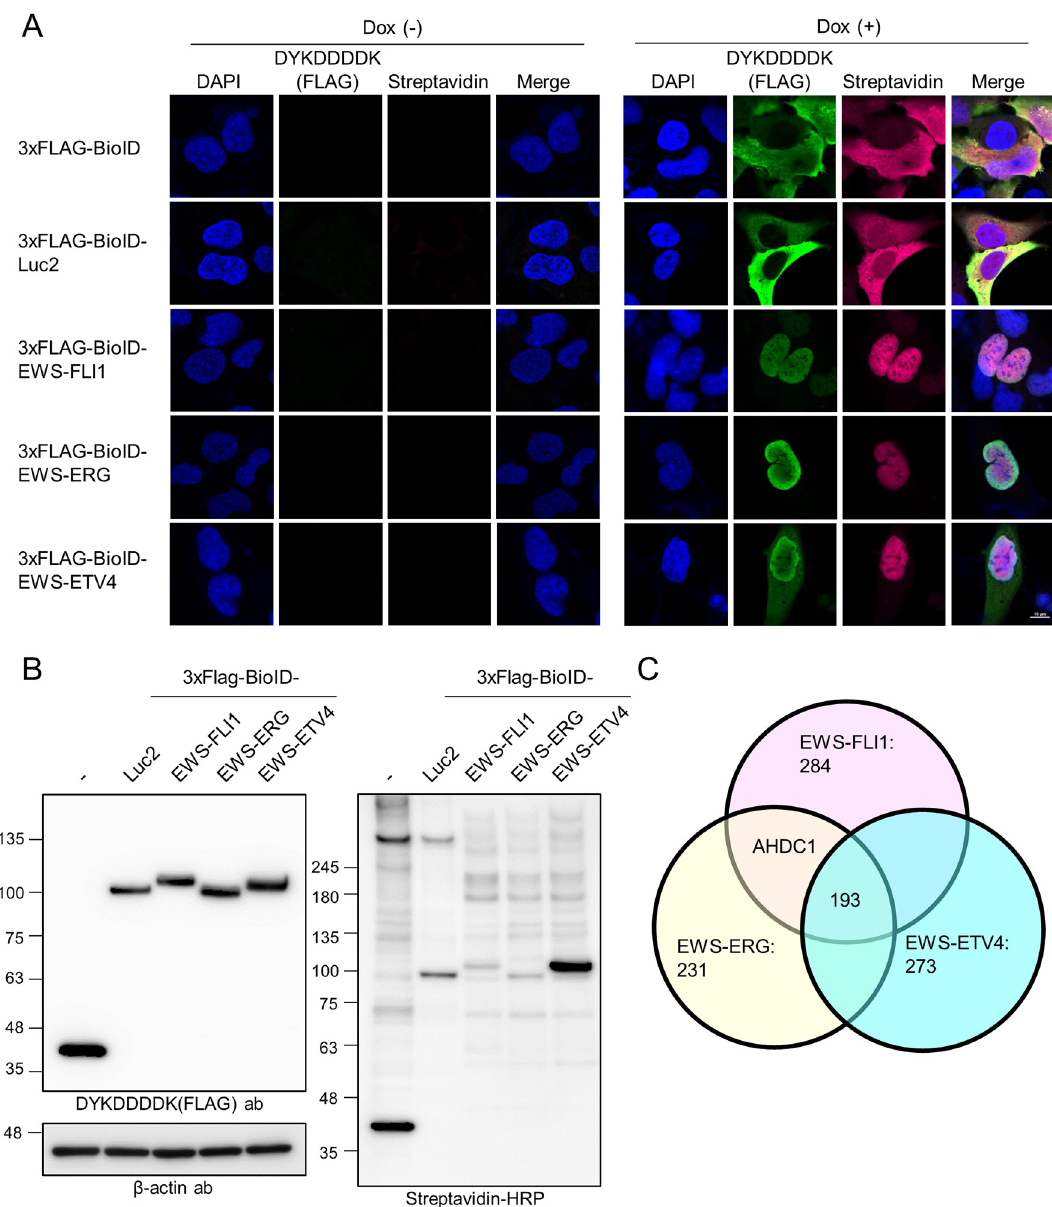
Fig 1. Identification of AHDC1 as a proximal protein of EWS-ETS fusion proteins. (A) 3xFLAG-BioID-tagged EGFP or EWS-ETS fusion proteins under the control of Tet-on promoter were expressed in A673 cells by 1 μ g/ml doxycycline or absence for 1 d. FLAG- tag or biotinylated proteins were stained with DYKDDDDK antibody or Alexafluor633-conjugated streptavidin, respectively, with DAPI. (B) Western blotting analysis of each BioID sample. FLAG-tag was stained with DYKDDDDK antibody. Biotinylated proteins were stained with streptavidin-HRP, and β -actin was stained as an internal control. (C) Identified protein numbers from each EWS-ETS fusion protein sample by mass spectrometry analysis. calculated from precursor ions (Materials and methods) and normalized using BirA(R118G) in each analysis. Each abundance intensity was calculated for each ratio using both BioID and BioID-Luc2. Out of 3879 proteins detected in all samples, 193 proteins were identified as prox- imal proteins shared from the three fusion proteins (Abundance ratio: each fusion proteins list compared to BioID and BioID-Luc2 > 5, Abundance Ratio Adj. p-value < 0.05). The STRING